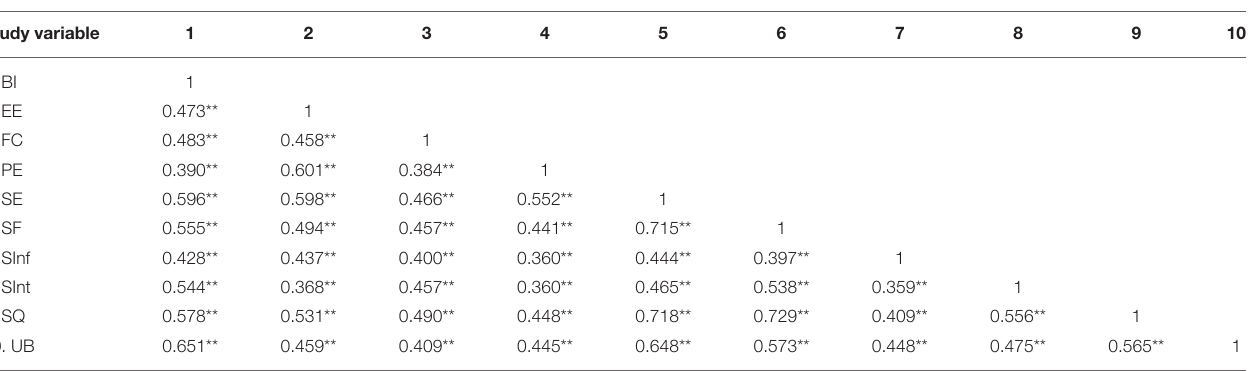
TABLE 4 | Correlation results among the constructs in CFA.